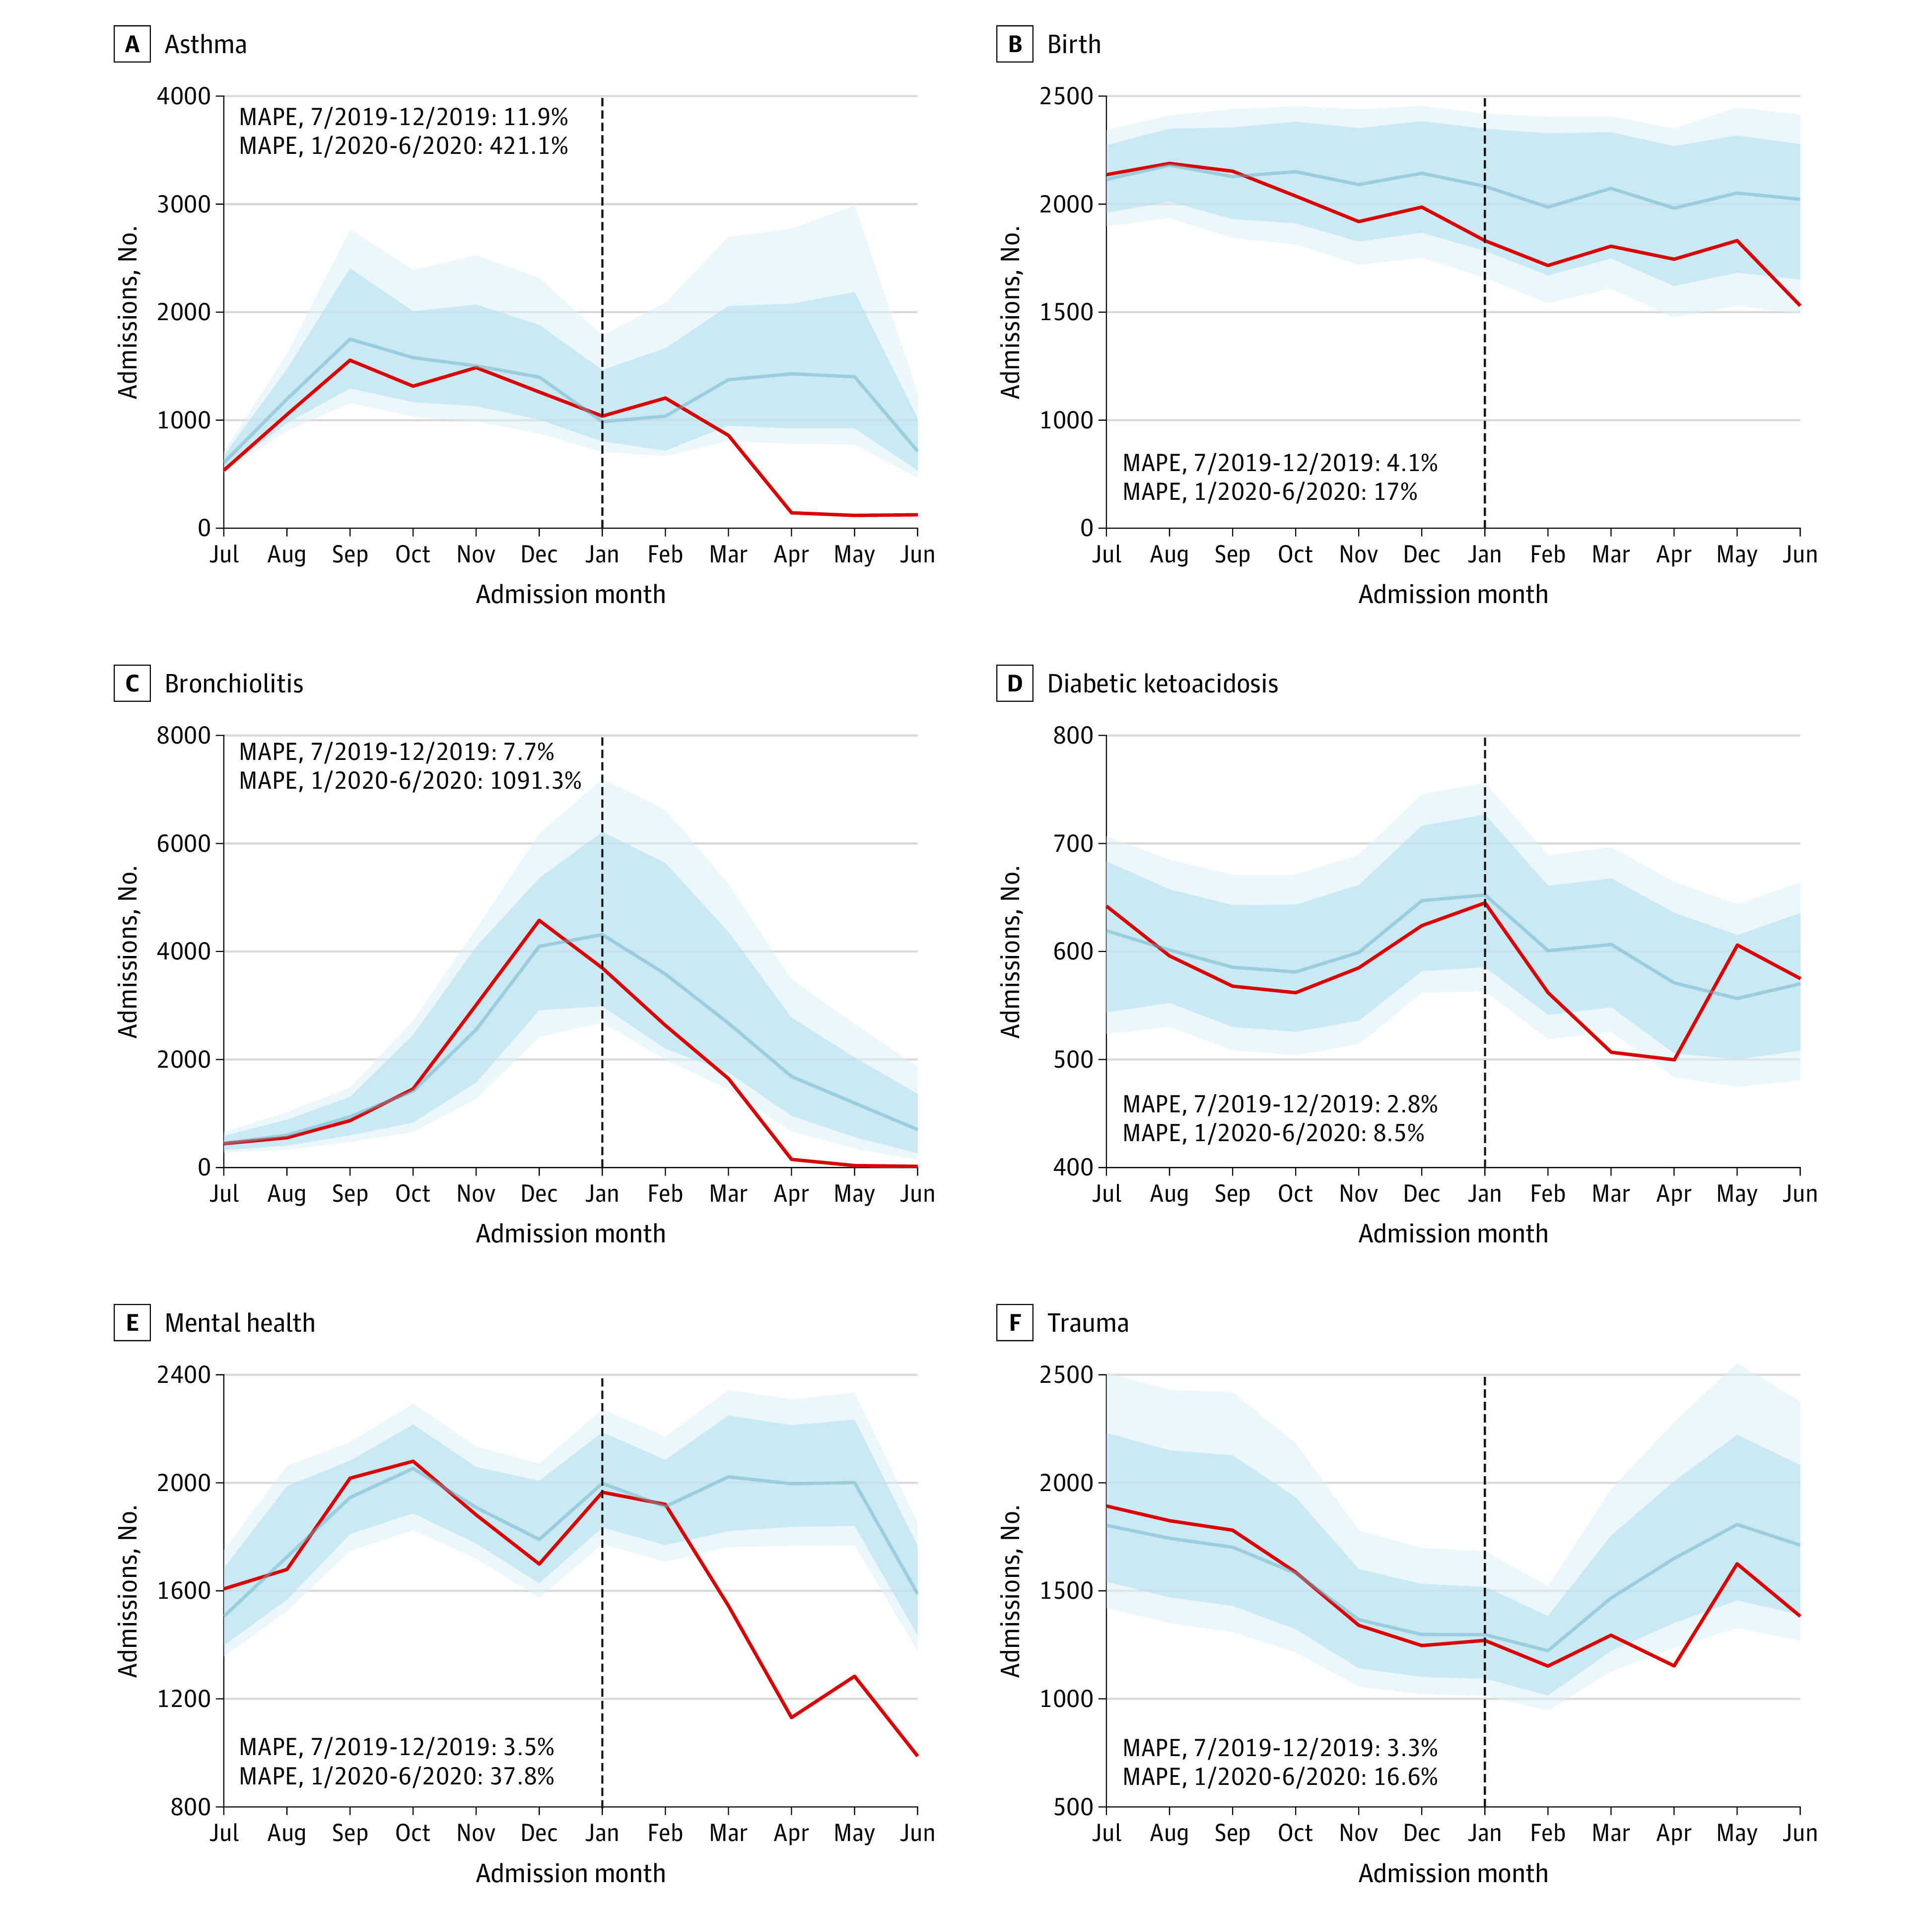
Ensemble ForecastsEach panel shows the estimated number of monthly admissions for a specified diagnosis between January 2010 and June 2020, according to ensemble forecasting models including autoregressive integrated moving average, neural network, and locally estimated scatterplot smoothing algorithms weighted on time-series cross-validation. All models were trained on data from January 2010 through June 2019, and the testing window for each model is shown. The blue line is the model estimate, and the dark and light blue shaded regions are the model 80% and 95% CIs, respectively. The red line is the actual number of admissions for each month. The vertical line represents January 2020. MAPE indicates mean absolute percentage error.